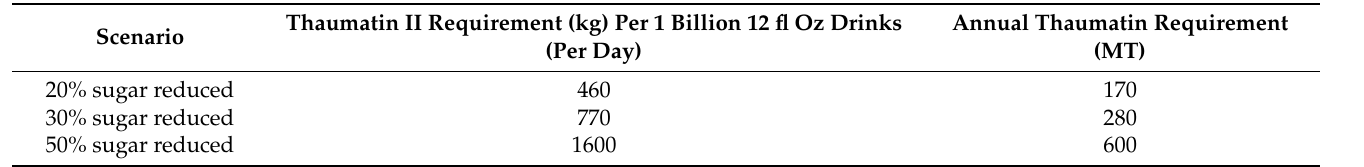
Table 3. Daily and annual amount of thaumatin required for each sugar-reduction scenario modeled in sweetened beverages. MT, metric ton.